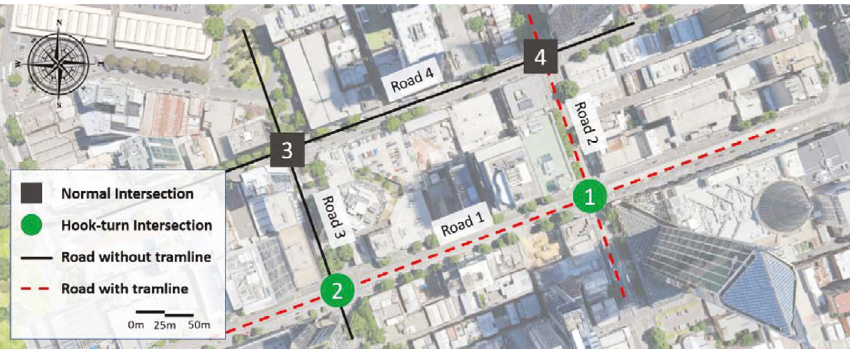
Figure 5: Case-study area.